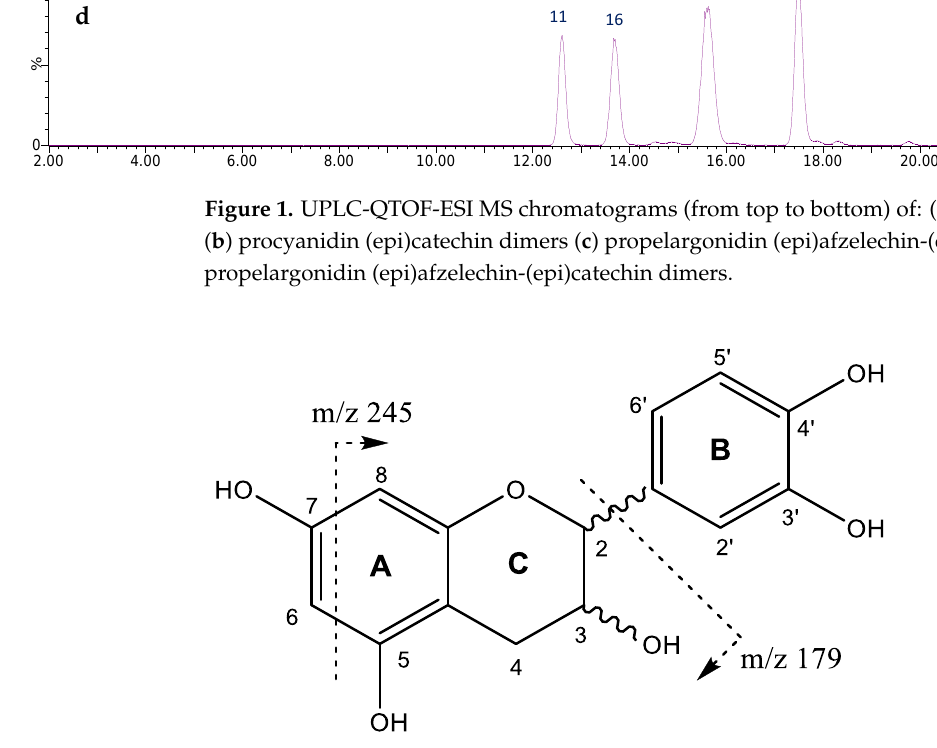
Figure 2. Flavan-3-ol monomers structure and main fragments. Four procyanidin B-type dimers are present in peaks 4 (Rt = 9.58 min), 7 (Rt = 10.38 min), 13 (Rt = 12.70 min), and 17 (Rt = 13.84 min), which show [M-H] − at m / z 577.1382 (C 30 H 25 O 12 ). As shown in Figure 3, the fragment at m / z 559 originates from water loss (18 Da) and the ion at m / z 451 results from the elimination of the phloroglucinal (126 Da) by heterocyclic ring fission